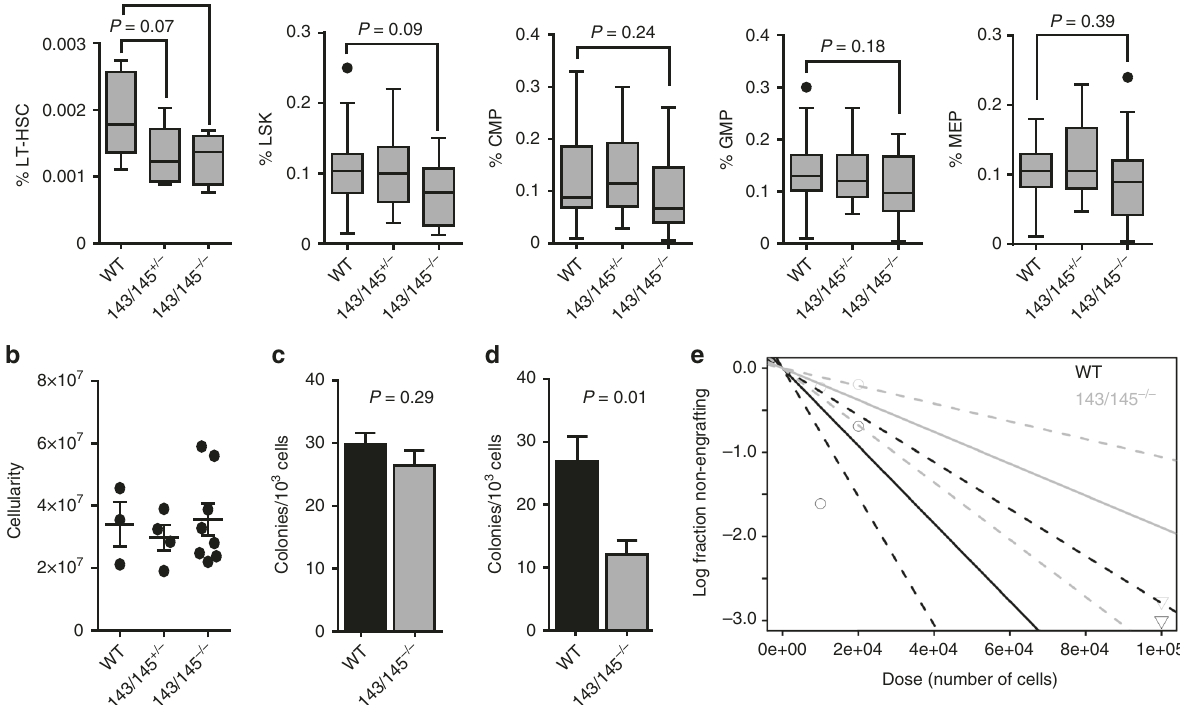
Fig. 1 Loss of miR-143/145 results in reduced LT-HSC frequency. a Frequency of long-term-HSC (LT-HSC, CD45 + EPCR + CD48 − CD150 + ), LSK/short-term HSC (Lin − Sca1 + c-Kit + ), common myeloid progenitors (CMP, Lin − Sca1 − c-Kit + CD34 + CD16/32 lo ), granulocyte – macrophage progenitors (GMP, Lin − Sca1 − c-Kit + CD34 + CD16/32 hi ), and megakaryocyte – erythrocyte progenitors (MEPs, Lin − Sca1 − c-Kit + CD34 − CD16/32 lo ) in the marrow of 8 – 12-week- old wild-type (WT), miR-143/145 + / − , and miR-143/145 − / − mice, as analyzed by fl ow cytometry (median±1.5 IQR, WT n = 11, 143/145 + / − n = 9, 143/145 − / − n = 8). b Marrow cellularity (2 femurs and 2 tibias) (WT n = 3, 143/145 + / − n = 4, 143/145 − / − n = 8). c Colony-forming unit (CFU) assay of marrow cells from WT and miR-143/145 − / − mice (mean±SEM, WT n = 11, 143/145 − / − n = 10). d Primary CFU cells were replated in equal proportions per condition, normalized to the number of input cells, to generate secondary CFUs (mean±SEM, WT n = 9, 143/145 − / − n = 7). e Estimate of HSC frequency in WT and miR-143/145 − / − mice by limiting dilution assay. Shown is a log-fraction plot of the limiting dilution model. The slope of the line is the log-active cell fraction. The dotted lines